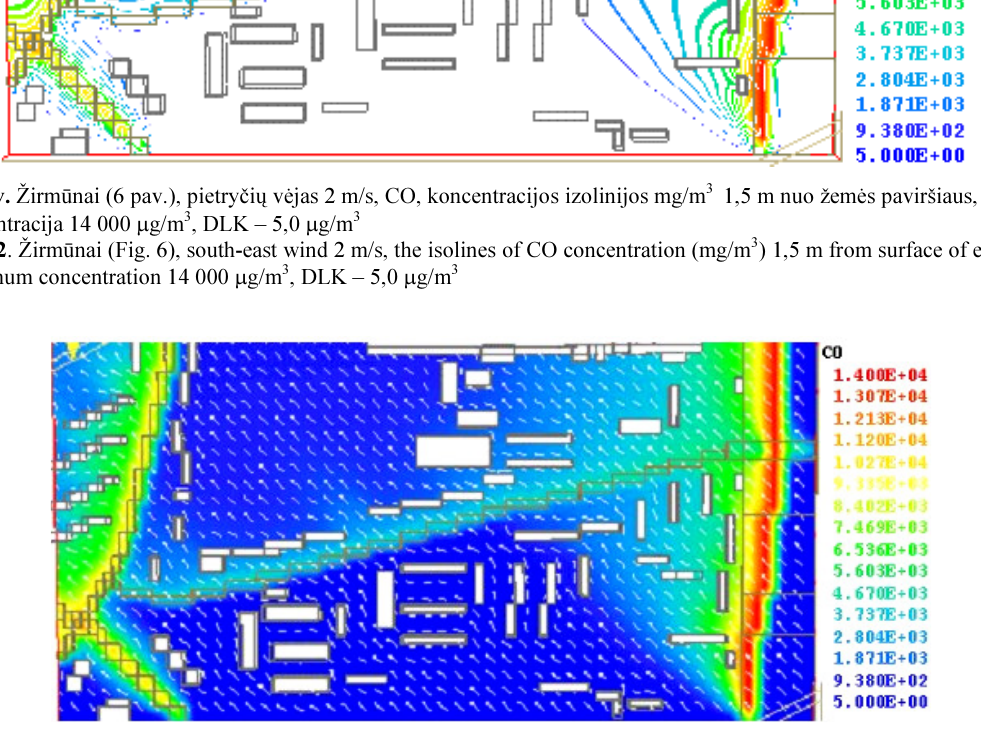
13 pav. Žirmūnai (6 pav.), pietryčių vėjas 2 m/s, CO koncentracijos izolinijos mg/m Fig. 13. Žirmūnai (Fig. 6), south-east wind 2 m/s, the isolines of CO concentration mg/m rface of earth, maximum concentration 14 000 µ g/m